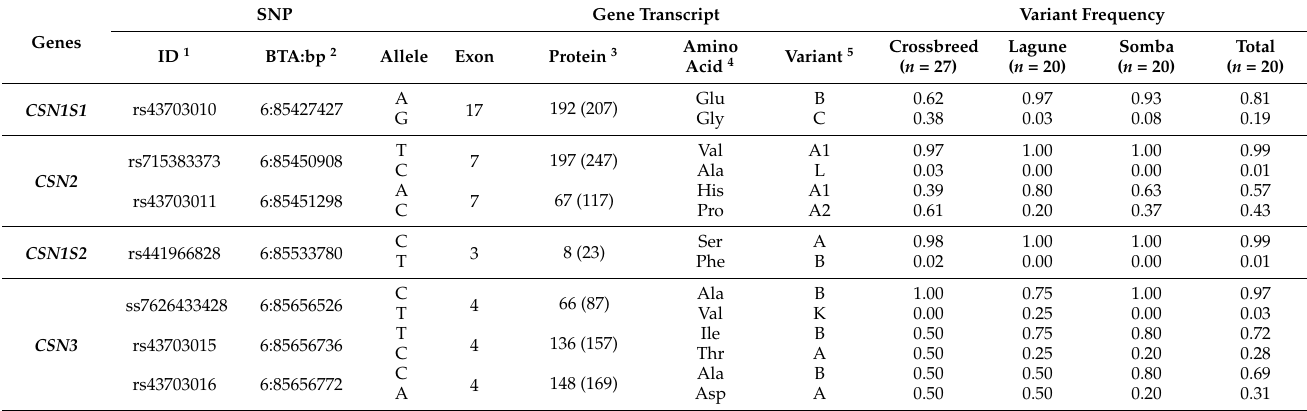
Table 3. Description (ID, location and allele frequencies) of the variants causing protein polymorphisms of the six milk protein genes ( CSN1S1 , CSN2 , CSN1S2 , CSN3 , LALBA , LGB ), their effects on the protein sequence and the designations of consequent protein variants, and frequencies within the different Beninese local breeds and across all investigated cattle. SNP Gene Genes